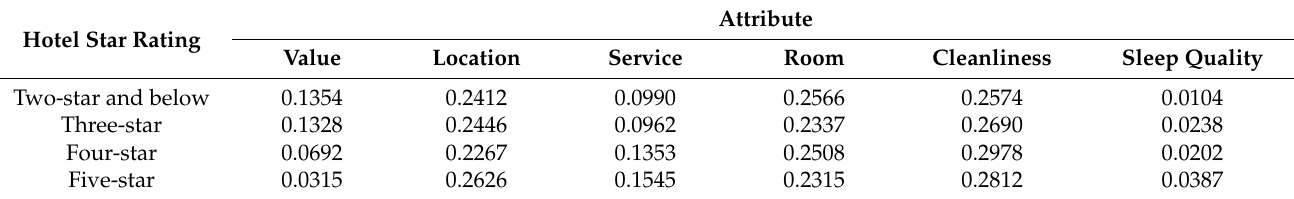
Table 11. The importance of the six attributes concerning four hotel star